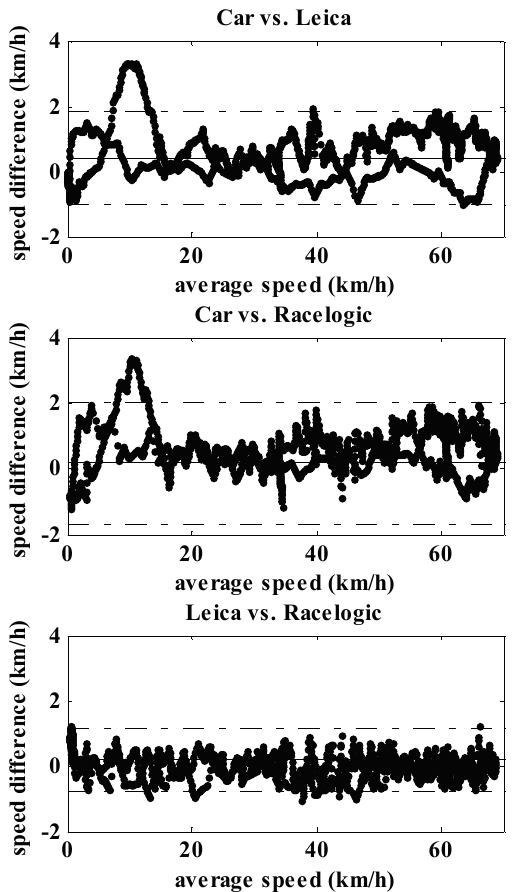
Figure 5. Bland Altman test of agreement between measured protocols. On x axis is average speed of both compared devices; on y axis is difference in speed between both devices; all data are presented in km/h. Full horizontal line represent the mean differences and the dash-dot line 1.96 SD (standard deviation) interval in each